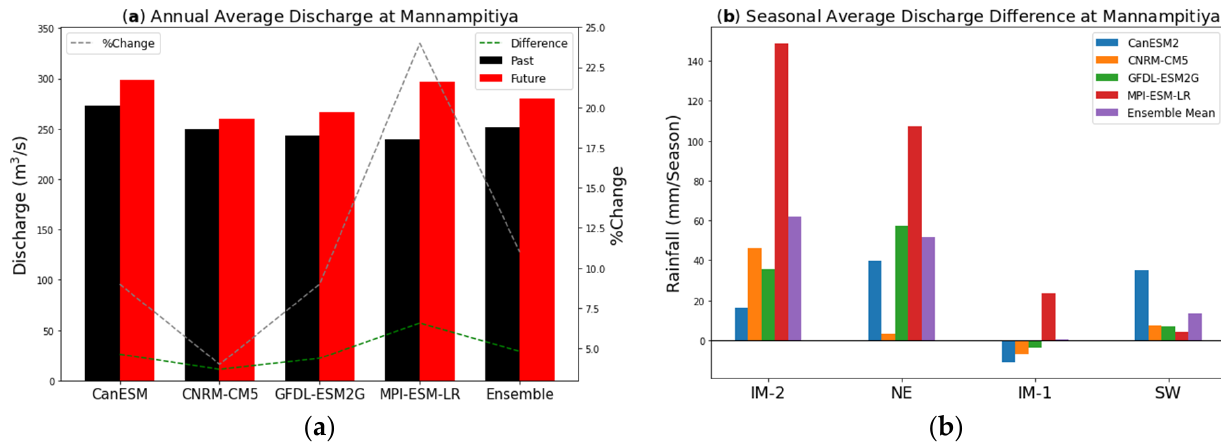
Figure 10. ( a ) Annual average discharge at Mannampitiya gauging station of the selected models; and ( b ) seasonal average discharge difference at Mannampitiya gauging station of the selected models.